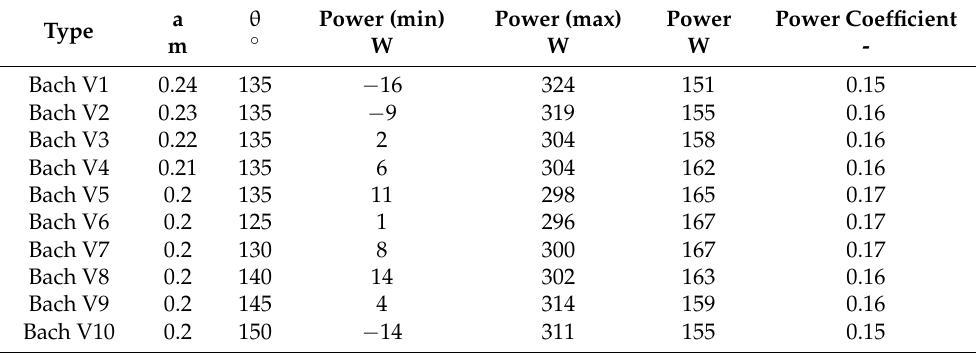
Table 3. Rotor power and efficiency according to Bach rotor design